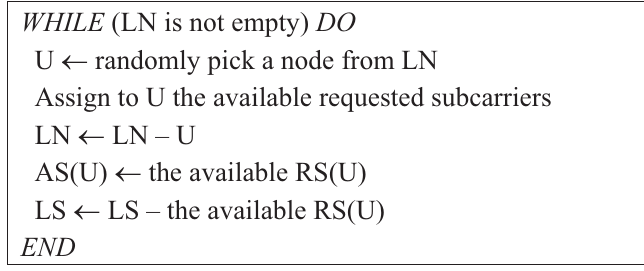
Table 1. Pseudo code for the random mode (RM) of